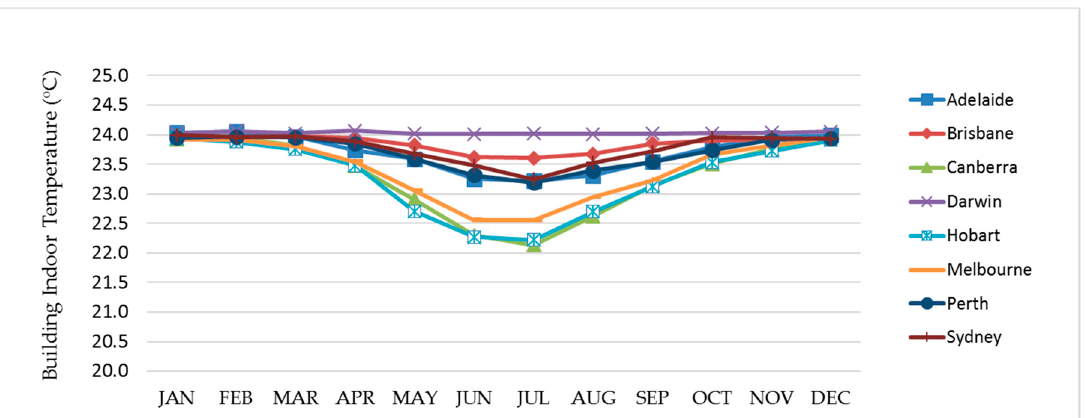
Figure 12. Monthly building indoor temperature of the conventional VAV system.